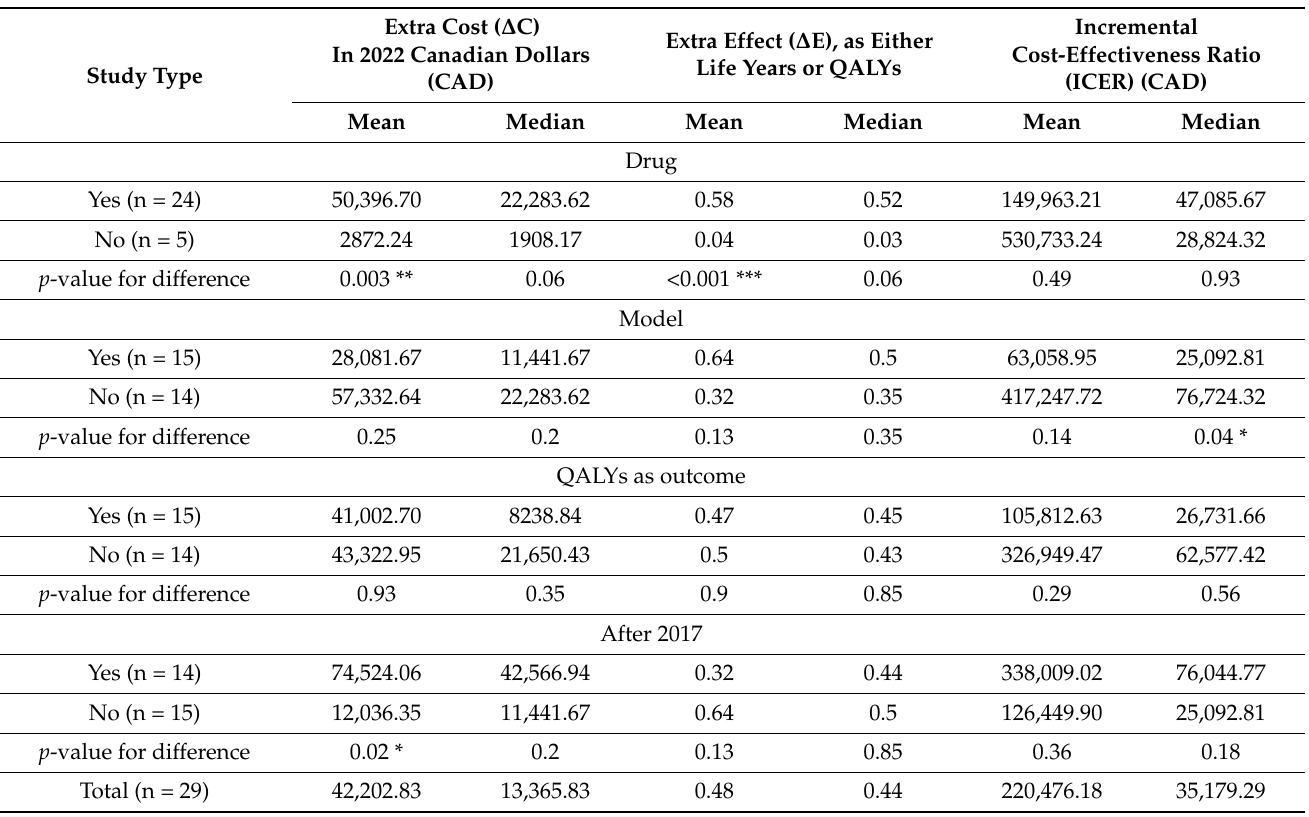
Table 4. Estimates by study